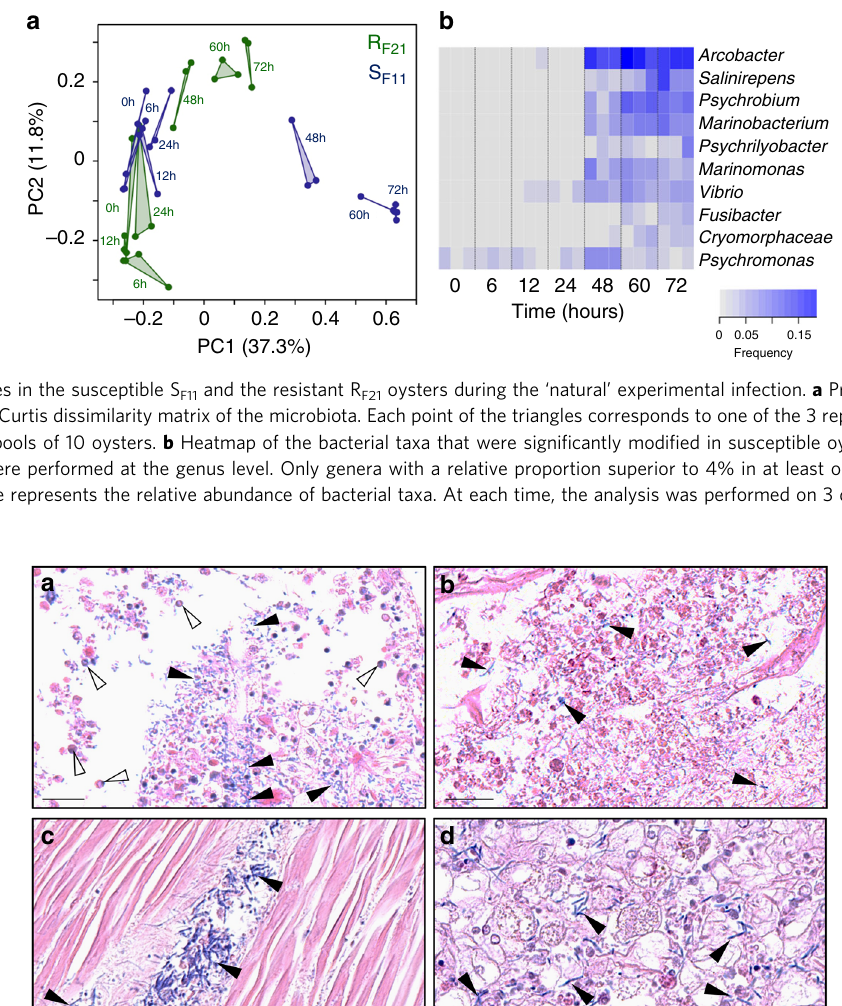
(Fig. 4). At 54 h, bacterial accumulation accompanied by in fi ltrating haemocytes was visible in different areas both inside and outside the gill tissues (Fig. 4a). At 78 h, the gill tissue structure was completely disrupted and bacteria had spread throughout the body (Fig. 4b, c, d and Supplementary Fig. 8). In contrast, in R F21 oysters, total bacteria and vibrios remained low and stable (Fig. 2b – d), and no tissue damage or tissue colonization by bacteria were observed at any sampled time point (Supplementary Fig. 8).